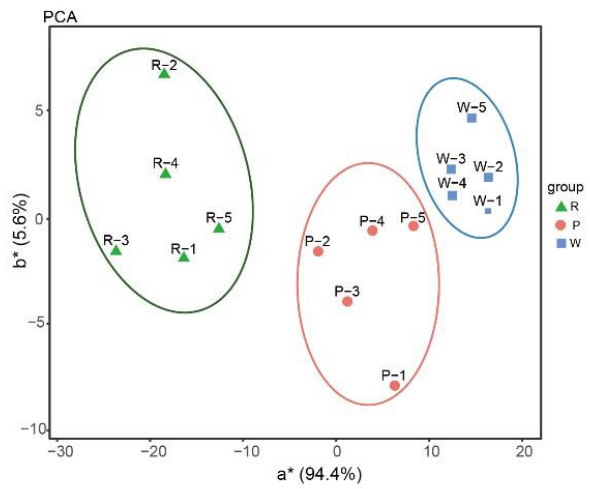
Figure 1. Principal component analysis of petal color of P. limprichtii . Distribution based on bivariate values of a* (redness and greenness) and b* (yellowness and blueness). a* means difference in red and green, b* means difference in yellow and blue. Table 2. Color parameters of three distinct colors of P. limprichtii petal.